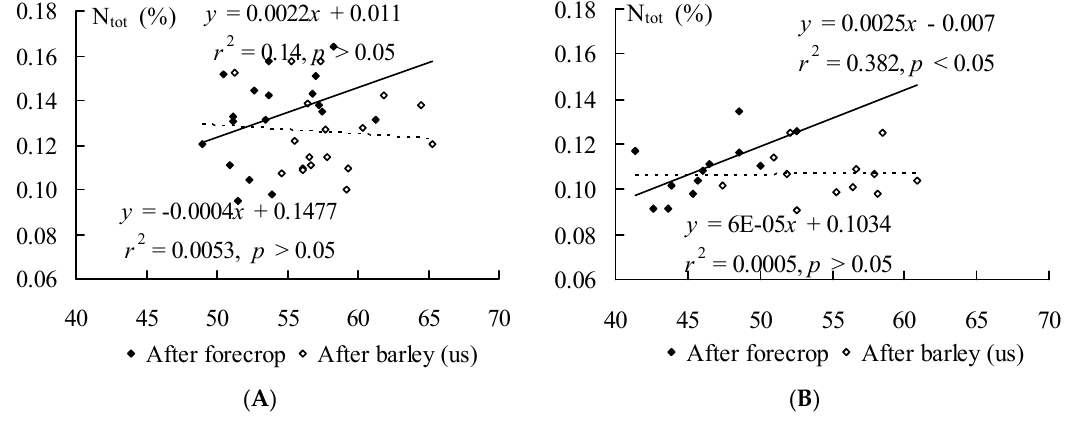
Figure 2. Relationships between soil hydrolytic activity ( µ g of fluorescein g − 1 soil dry mass h − 1 ) and total nitrogen (N tot , %) content in organic ( A ) and conventional ( B ) farming system after forecrop and after barley (us) cultivation.